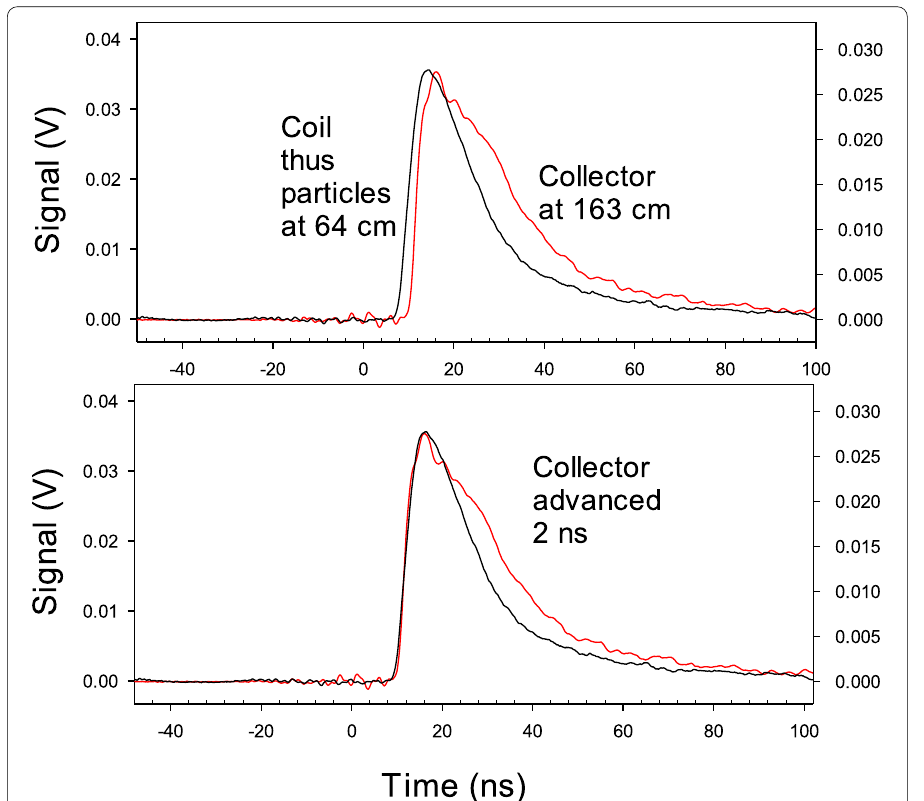
Fig. 4 Relativistic particle signal at both the coil and the collector. Note the two vertical scales, with collector signal to the right. In the bottom panel, the signal at the collector is displaced 2 ns earlier in